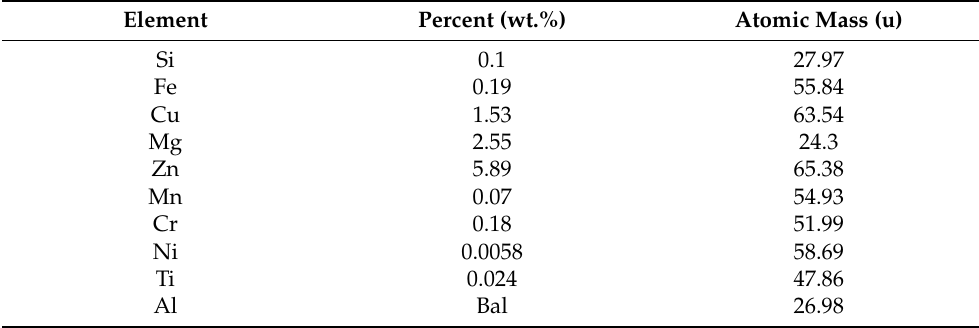
Table 2. AA7075 aluminium chemical composition in wt.%.